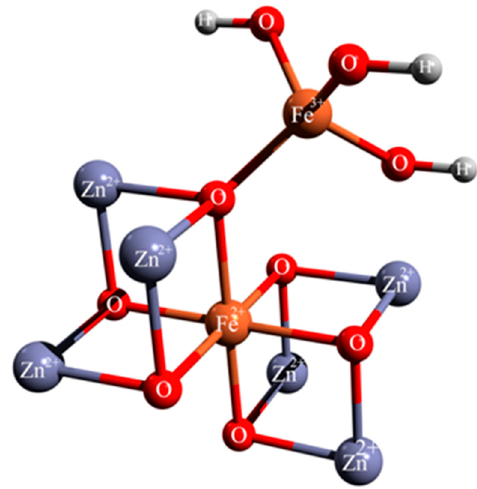
Figure 5. Structure of Fe 3 O 4 model systems.